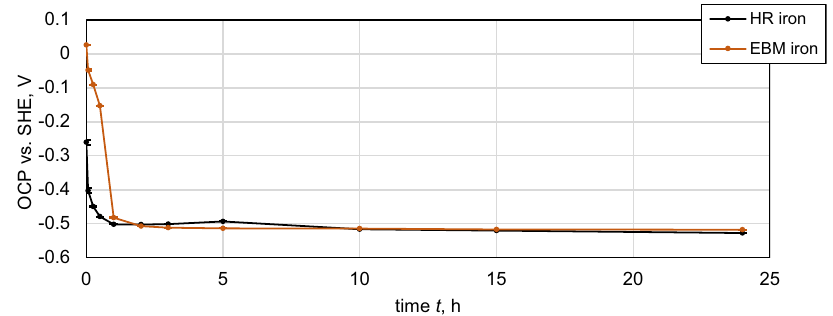
Fig. 8 OCP data. Shown for EBM iron and HR iron as a function of the immersion time in